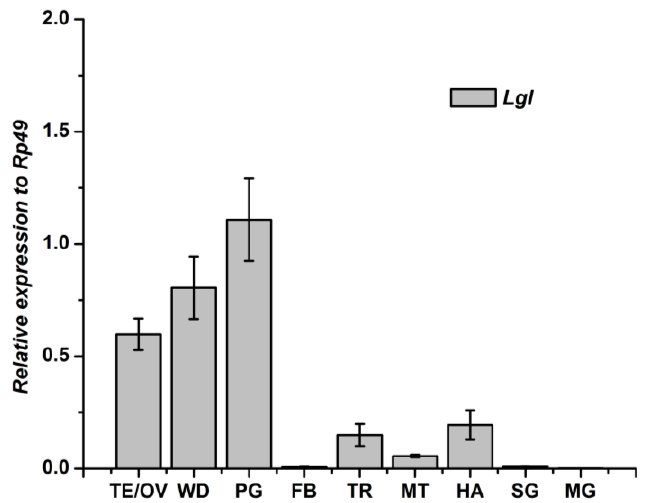
Figure 8. Tissue distribution of Lgl mRNA in Bombyx mori. fat body, FB; midgut, MT; testis/ovary, TE/OV; wingdisc,WD; trachea, TR; malpighian tubule, MG; hemolymph, HA; prothoracic gland, PG; silk gland, SG.